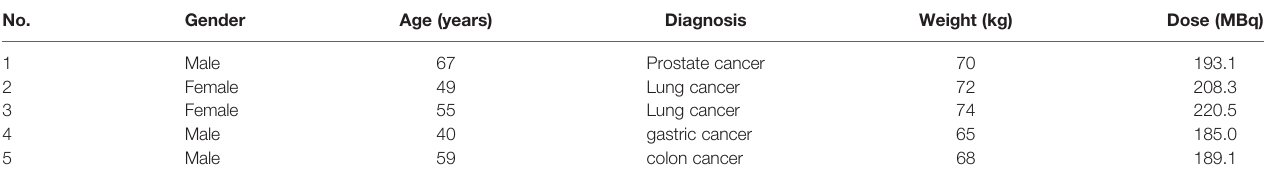
TABLE 1 | Information of Patients Enrolled in 68 Ga-P15-041 PET/CT Dynamic Imaging.